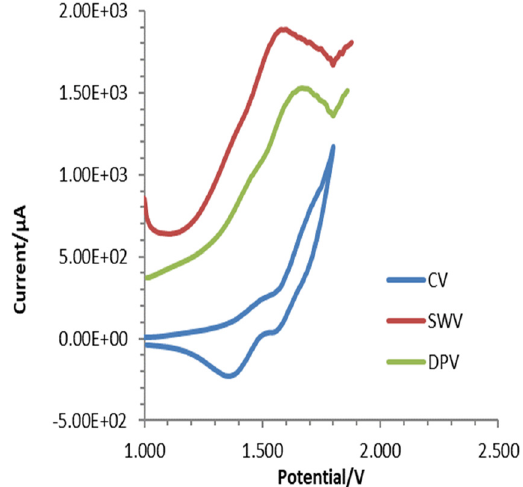
Figure 3: Voltammograms of 320 µmol L − 1 of ATN in 0.1 mol L − 1 of H 2 SO 4 at CPE - I composite electrode using the CV, SWV, and DPV techniques. Conditions: CV, scan rate = 100 mV s − 1 ; DPV, scan rate = 20 mV s − 1 and pulse amplitude = 30 mV; SWV, pulse amplitude = 30 mV, frequency = 25 Hz, and step potential = 5 mV.